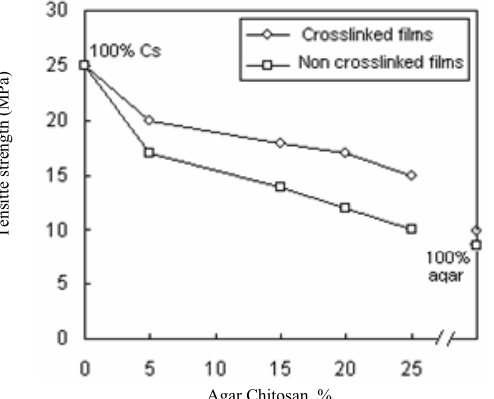
Figure 9. Variation of tensile strength of non-crosslinked CS/Agar blended films and their crosslinked CS/Agar counterparts with the agar content